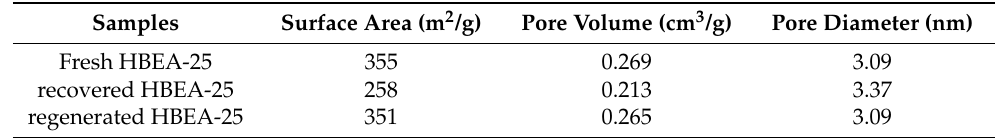
Figure 1. The curve of N 2 adsorption, desorption isotherms, and pore size distribution. Table 1. Surface properties of the different HBEA-25. Table 1. Surface properties of the different